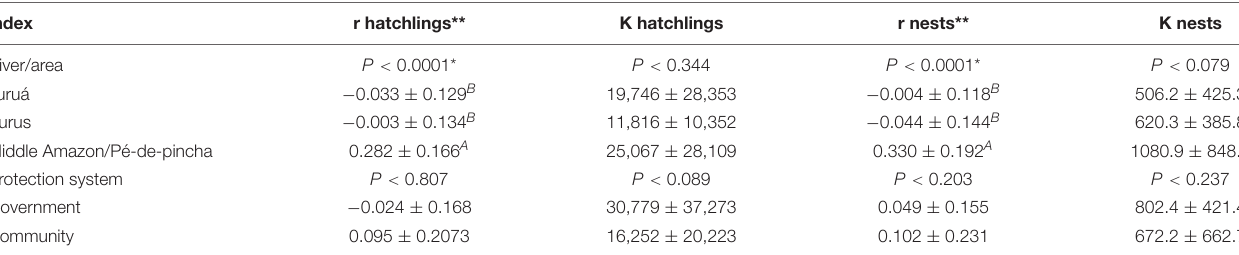
TABLE 2 | Summary of ANOVA of instantaneous growth rates r and carrying capacity K for number of nests/reproductive females and hatchling of Podocnemis unifilis